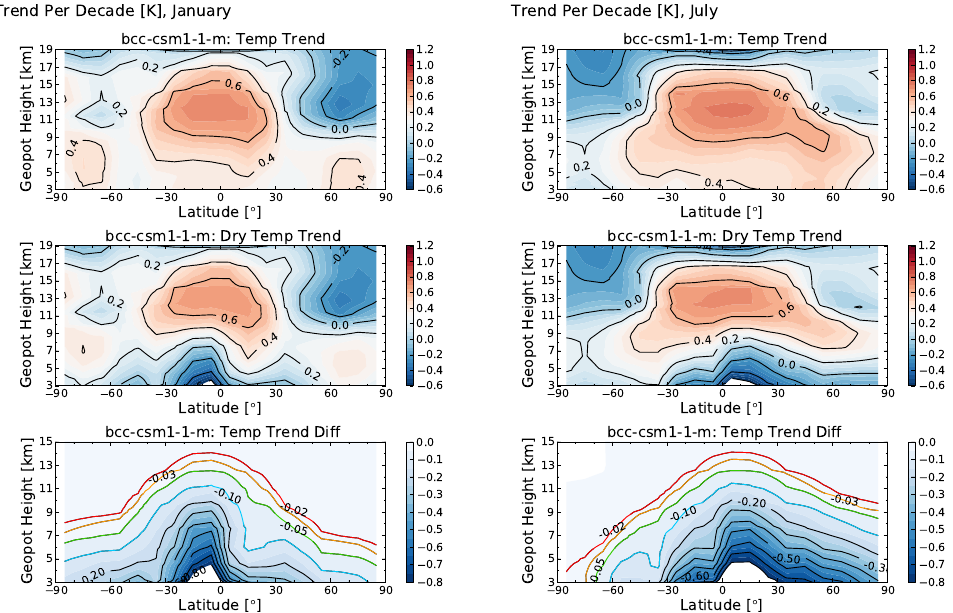
Figure 9. Physical temperature trend per decade (top), dry temperature trend per decade (middle), and difference between dry and physical temperature trend per decade (bottom) for the CMIP5 model BCC-CSM1.1(m) from the Beijing Climate Center, for January (left) and July (right).